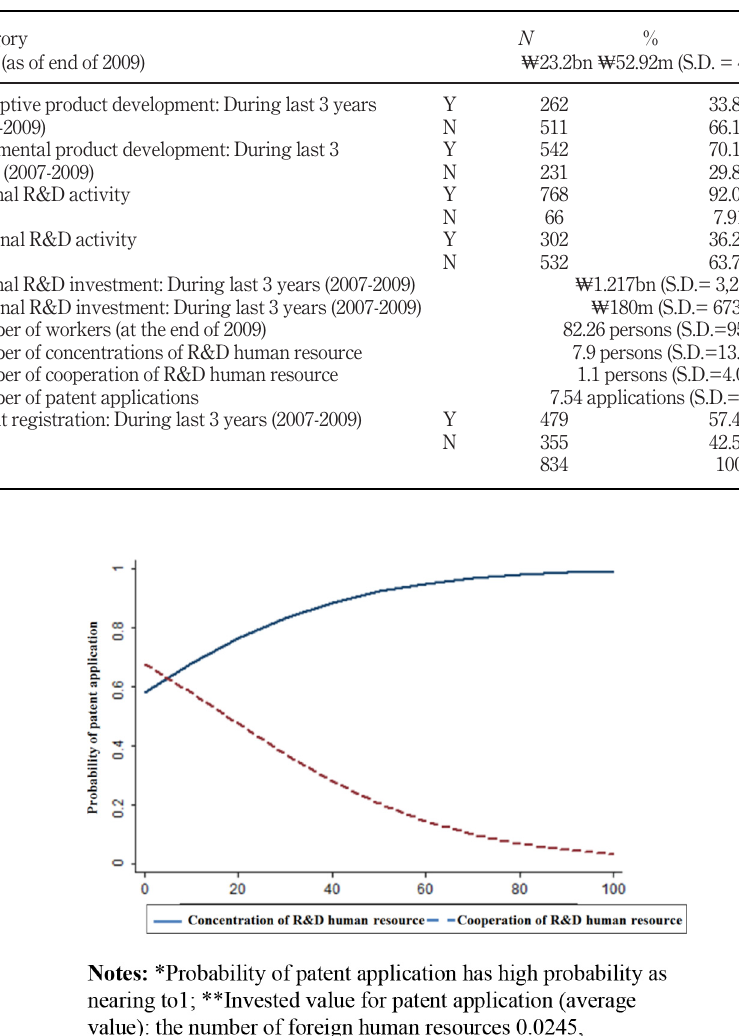
Figure 2. Simulation for patent application up to R&D human resource